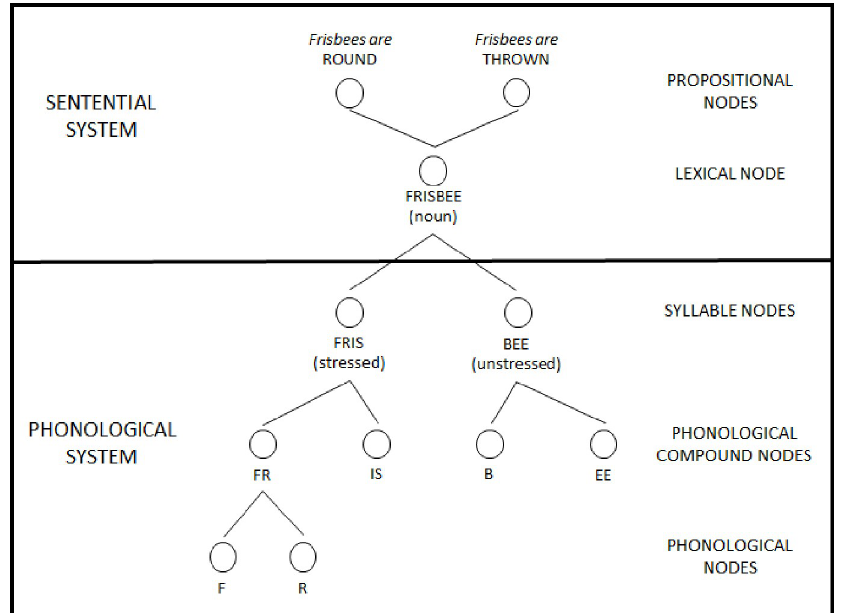
Fig 1. Nodes representing phonemes, syllables, and semantic information associated with the word frisbee as it might be represented in Node Structure Theory. Additional higher-level and lower-level nodes have been omitted to simplify the